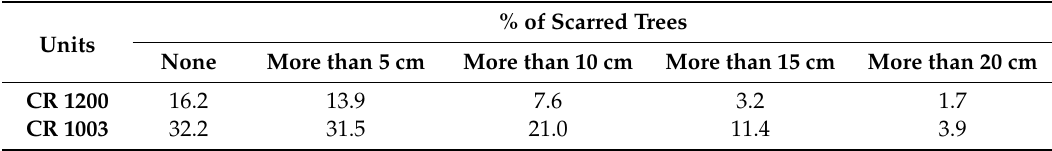
Table 9. Percentage of number of damaged trees in different scar width (cm)